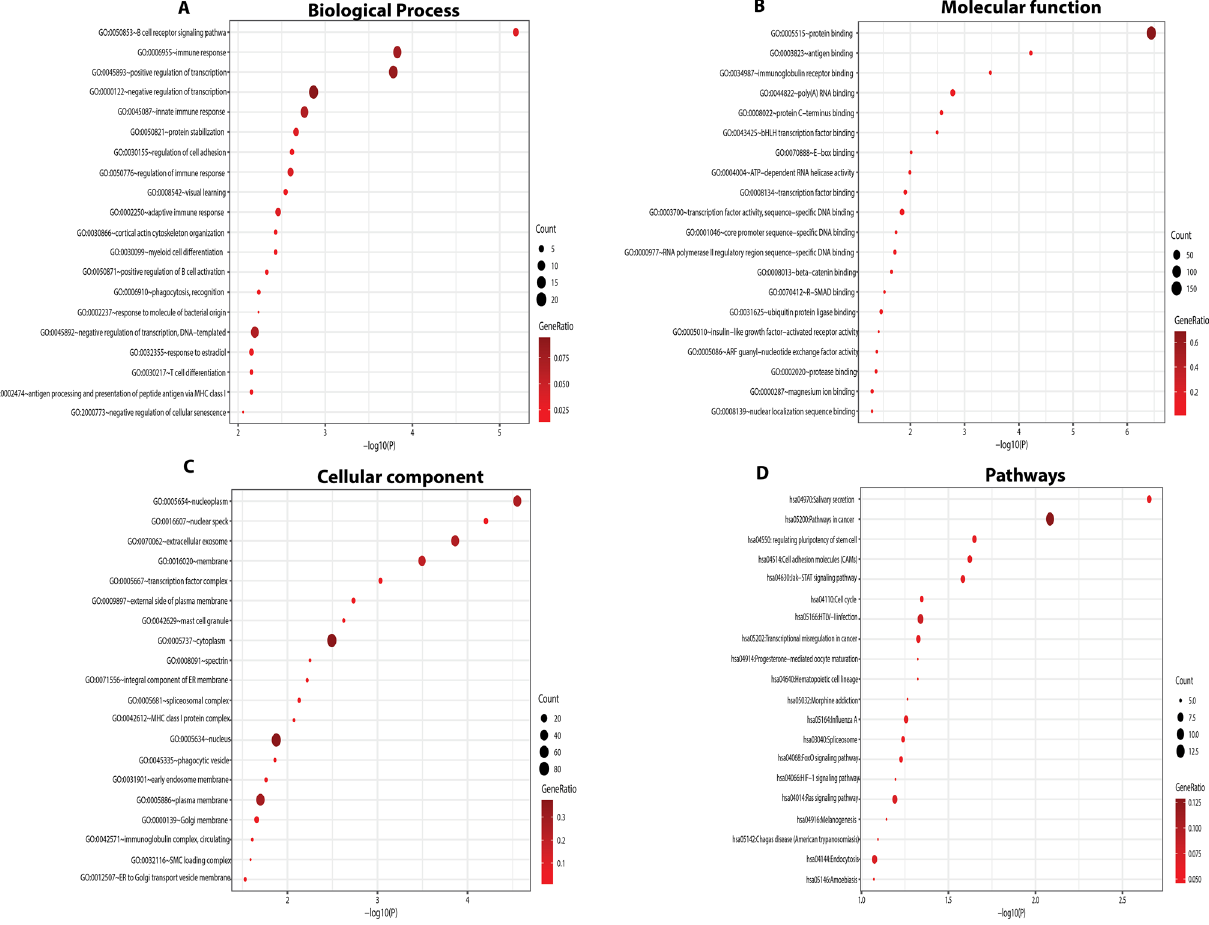
Fig. 3 Functional and pathway enrichment analyses of up-regulated DEGs in leukemia (chronic lymphocytic and myelogenous). A Biological process enrichment analysis of up-regulated DEGs. B Molecular function. C Cellular component. D KEGG pathway enrichment